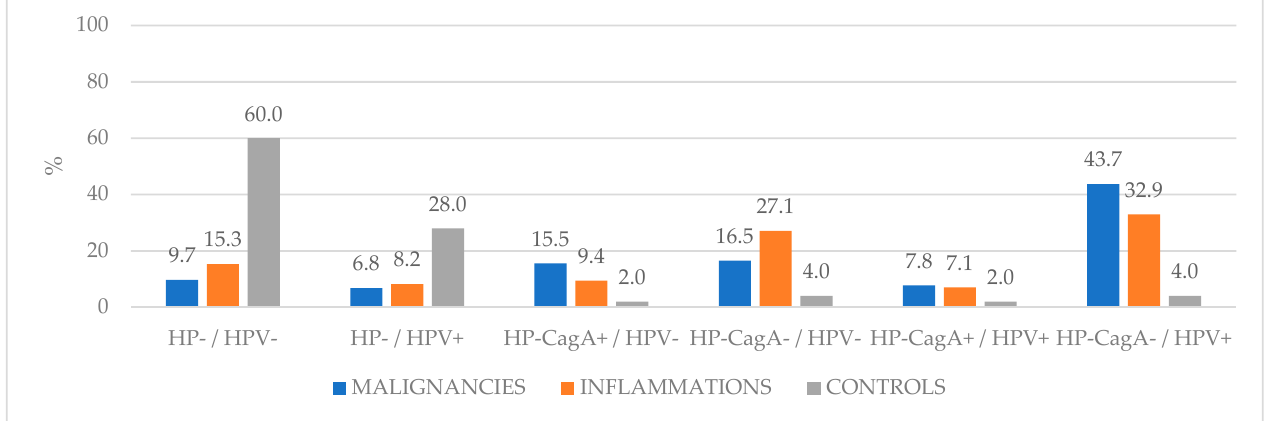
Table 5. Distribution of different Helicobacter pylori genotypes in positive samples of the respective groups (malignancy, n = 86).